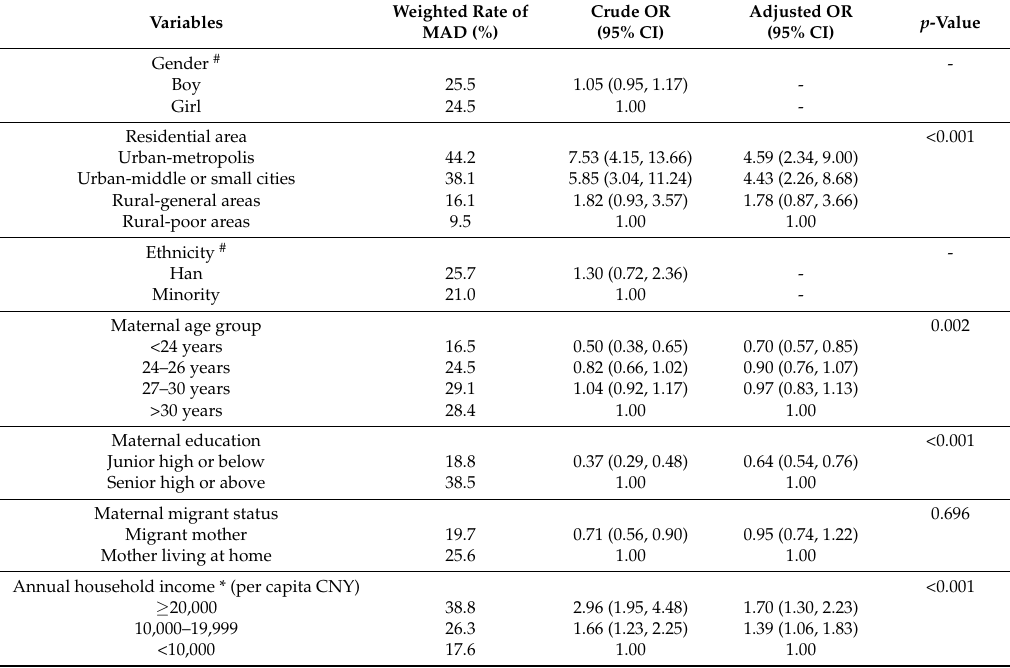
Table 5. Determinants of minimum acceptable diet (MAD) for children aged 6–23